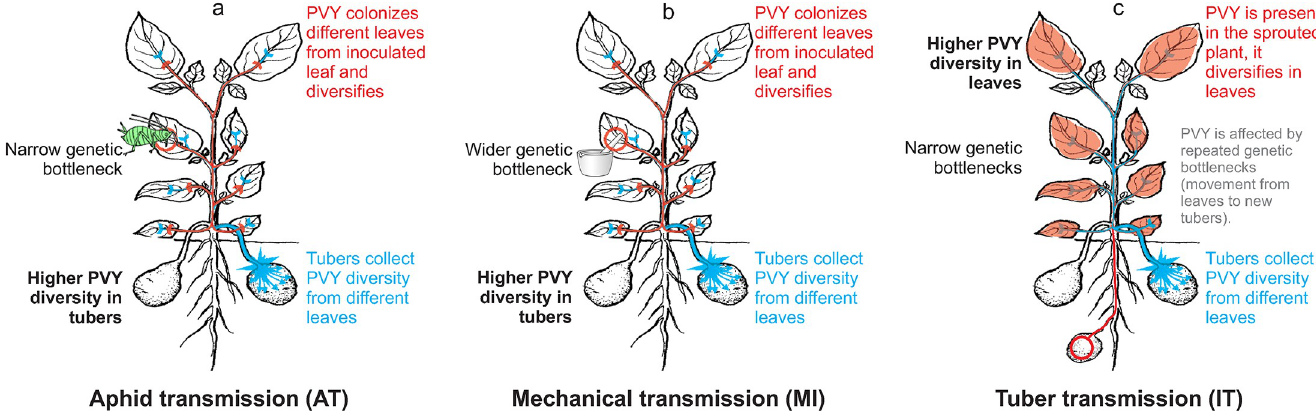
Fig 7. Summary of observed patterns in the PVY populations’ dynamics for different transmission modes. In black, on the left side of potato plant drawings are the representations of the population dynamics’ patterns. Suggested mechanisms explaining the observed patterns are highlighted in red, blue, and grey on potato plant drawings and on their right side. (a) Aphid transmission mode, (b) mechanical transmission mode, and (c) tuber transmission mode.